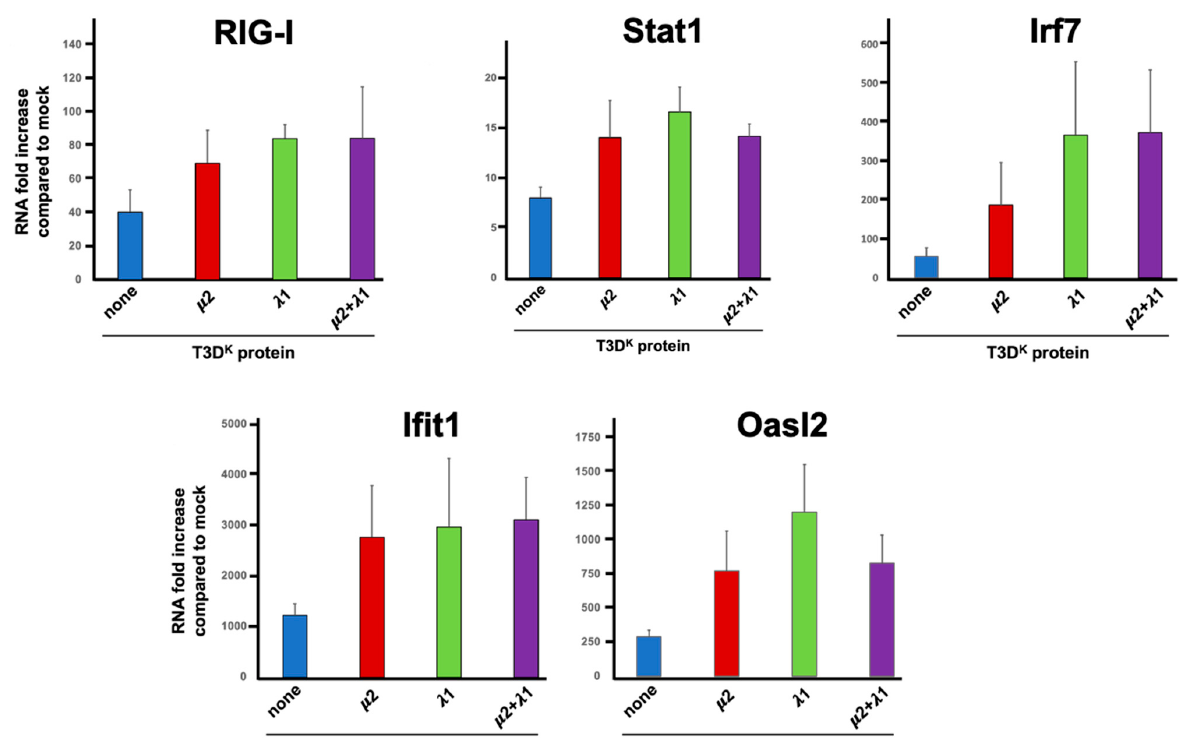
Figure 6. Induction of mRNA of genes of the interferon signaling network. L929 cells were infected at a MOI of 10 TCID 50 units/cell with the different viruses in the T3D S genetic background with either no substitution (none) or substitution of the μ 2, λ 1, or both proteins of T3D K , as indicated and as described in Materials and Methods. Total RNA was purified 15 h post-infection. The mRNA for the different indicated genes was quantitated by RT-qPCR. The experiment was done twice (biological replicates) except for RIG-I and Oasl2 done in triplicates, each reaction was then performed in triplicates (technical replicates). The data were normalized to the control housekeeping gene, the mock sample was attributed a value of “one”. A mean value was calculated from the technical replicates and the data are presented as the mean value of the two biological replicates. All error bars represent the standard error of the mean.